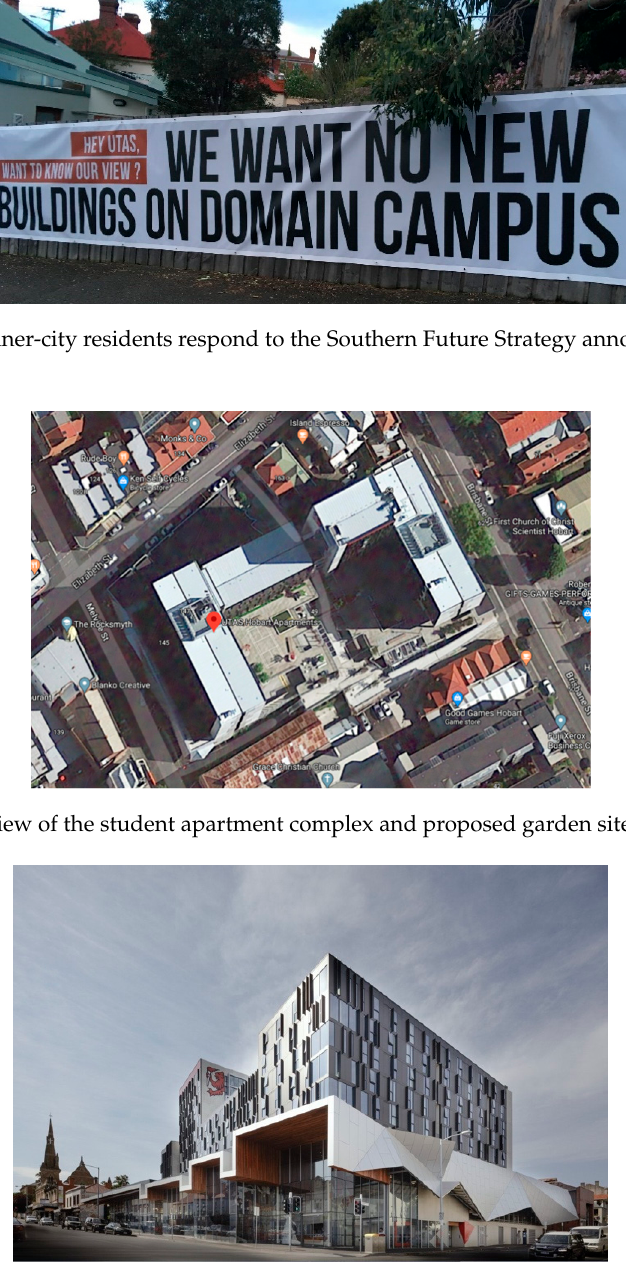
Figure 4. Aerial view of the proposed garden site and existing greenery in private and public areas. [Source, Terroir Architects].